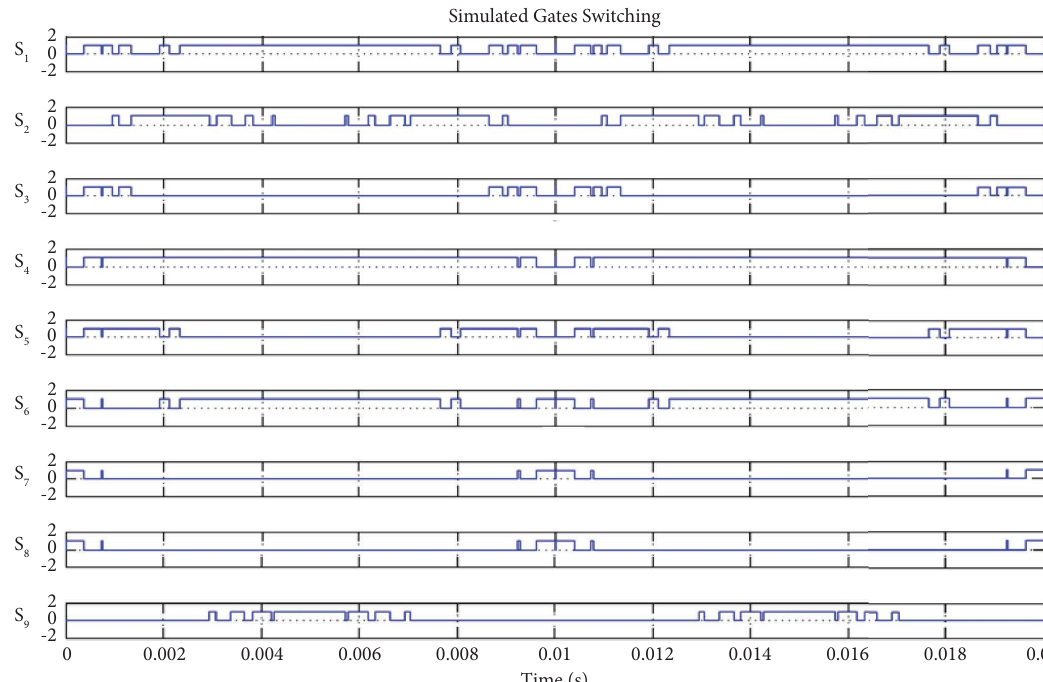
Figure 13: Gating pulse for 9-level